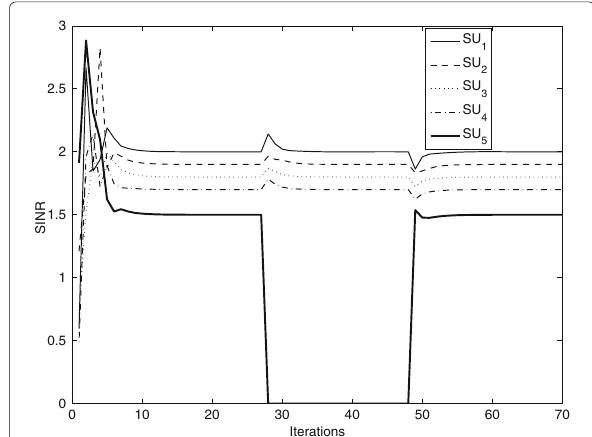
Fig. 6 The variations of cost functions versus the number of iterations for variable target SINRs